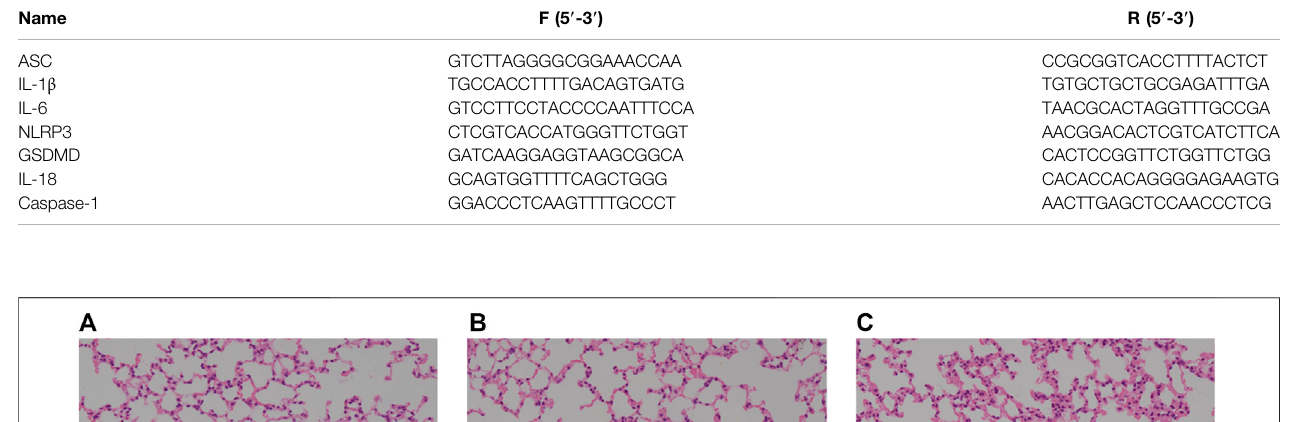
TABLE 1 | Primer sequences were used to detect the ASC, IL-1 β , IL-6, NLRP3, GSDMD, IL-18, and Caspase-1 mRNAs with RT-qPCR.